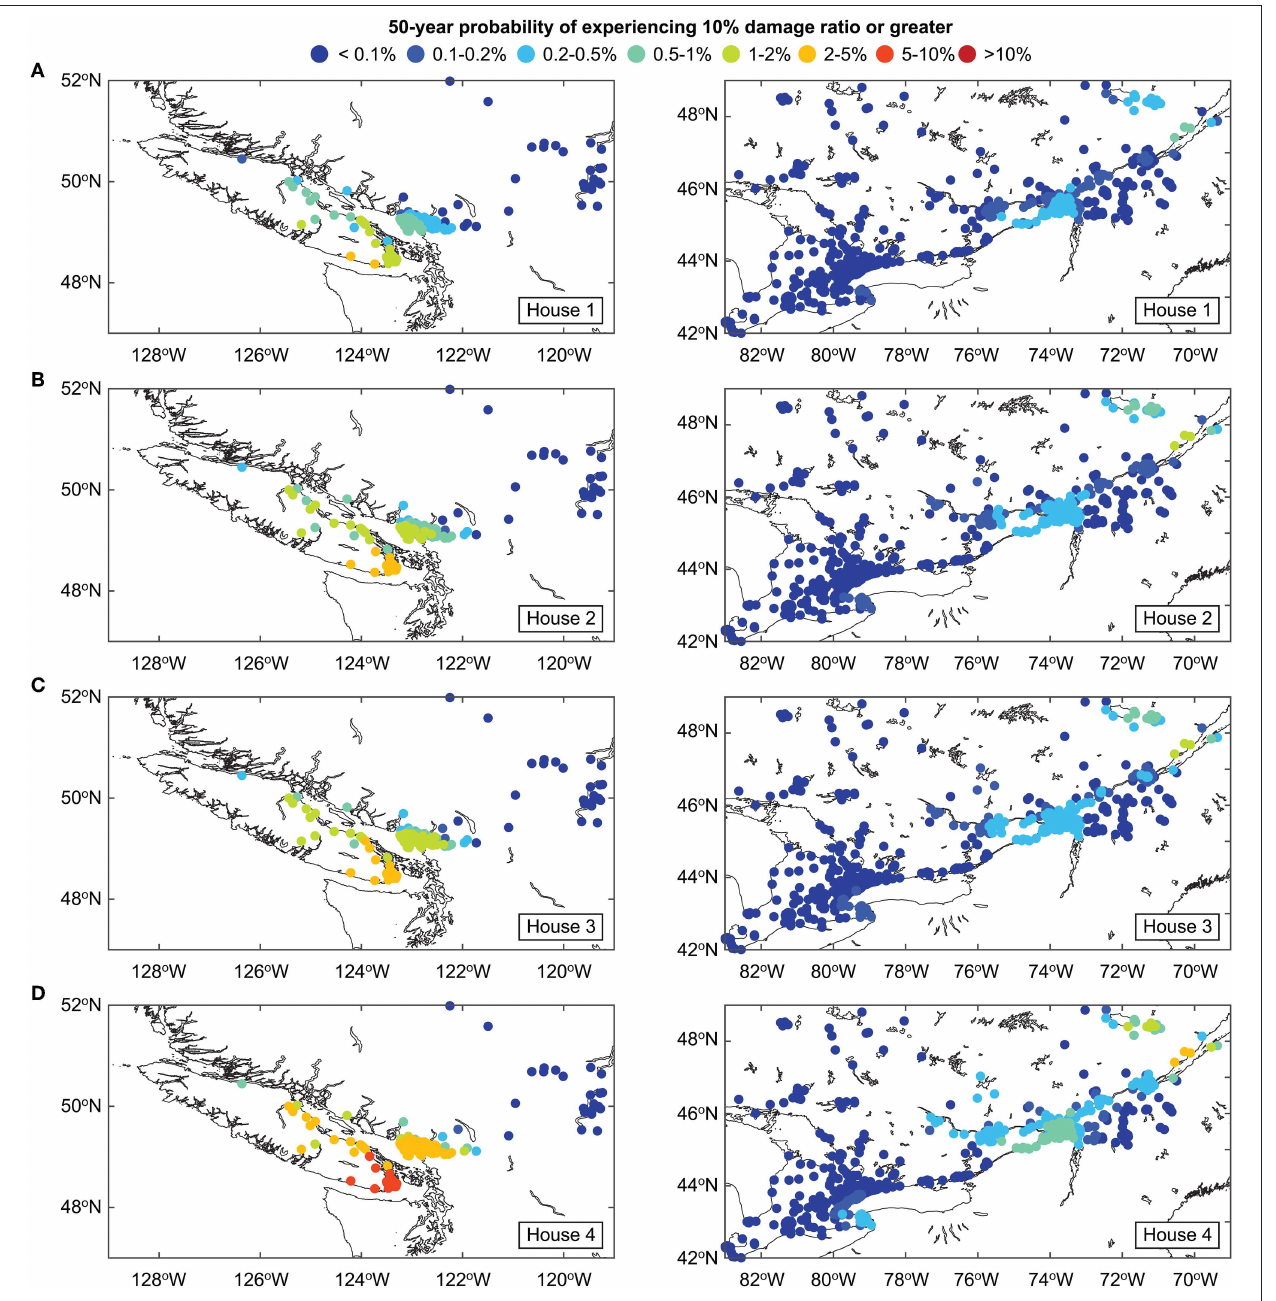
FIGURE 13 | Seismic risk maps in terms of 50-year probability of experiencing 0.1 damage ratio or greater for western and eastern Canada: (A) House 1, (B) House 2, (C) House 3, and (D) House 4.